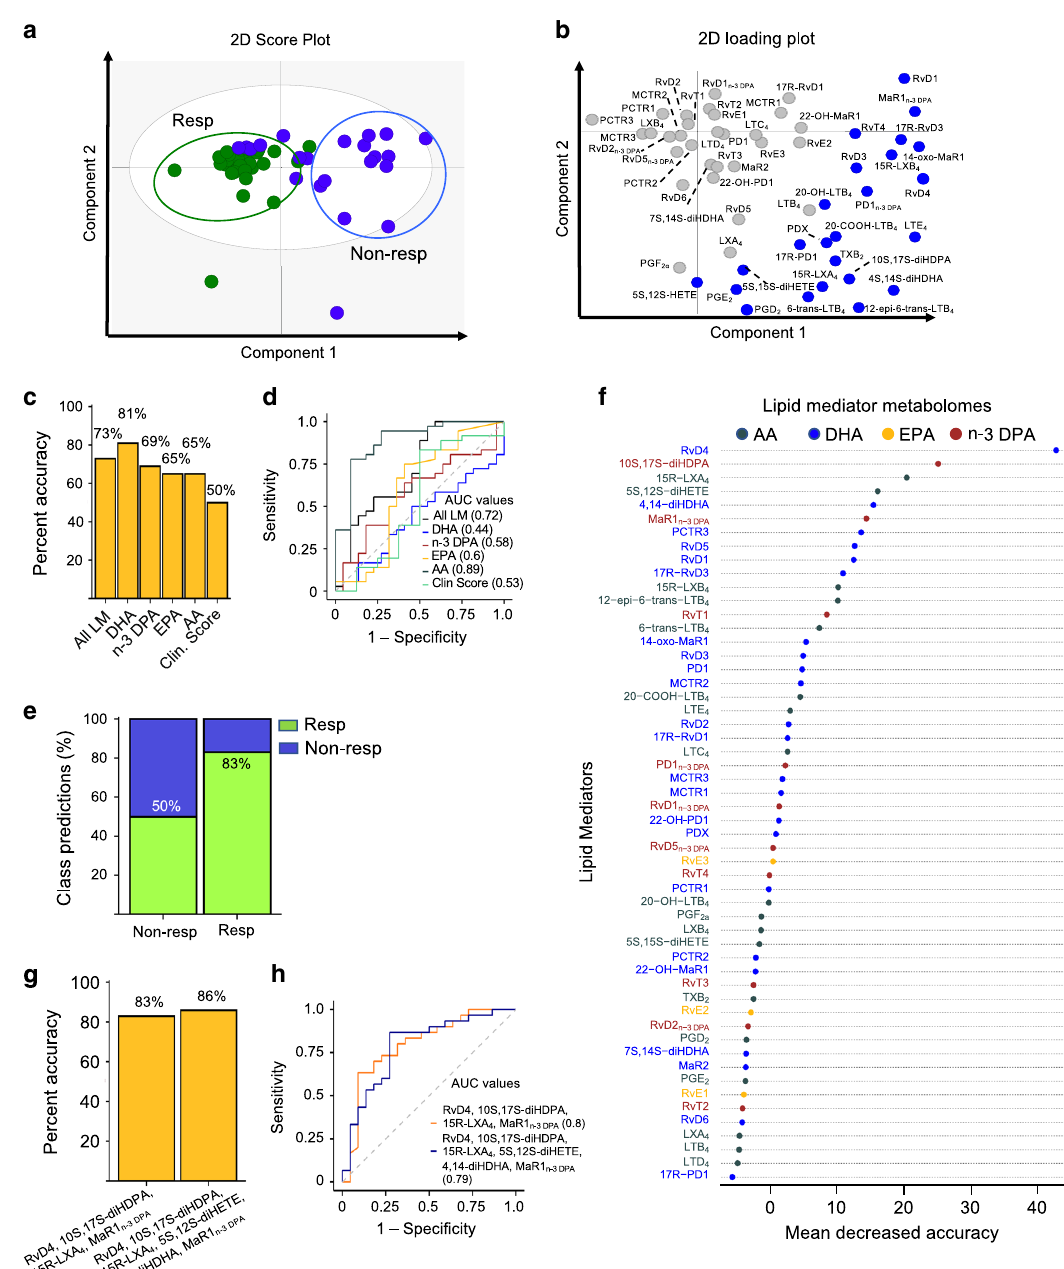
Fig. 1 Baseline lipid mediator pro fi les are predictive of DMARD responsiveness in RA patients. Plasma was collected from RA patients prior to the initiation of treatment with DMARDs and lipid mediator concentrations established using LC-MS/MS-based lipid mediator pro fi ling (see ‘ Methods ’ for details). a , b OPLS-DA analysis of peripheral blood lipid mediator concentrations for DMARD responders (Resp) and DMARD non-responders (Non-Resp). a Two-dimensional score plot. Grey circle represents the 95% con fi dence regions. b Two-dimensional loading plots. Lipid mediators with VIP score >1 are upregulated in Non-Resp and denoted in blue. Results are representative of n = 30 Resp and n = 22 Non-Resp. c Percent accuracy score of prediction models based on the combination of all lipid mediators identi fi ed and quanti fi ed (AL LM) or individual fatty acid metabolomes as indicated. Clin. Score = clinical score (see ‘ Methods ’ for parameters included). d ROC curves and AUC values (provided in brackets) for predictive models. e Classi fi cation predictions for each class (sensitivity and speci fi city) of the n-3 DPA model. Green indicates the samples that were predicted as Resp while blue indicates those patients predicted Non-Resp. Percentages indicate true positives (Resp class) and true negatives (Non-Resp class). f Relevance of lipid mediators in the prediction performance of the “ ALL LM ” model based on decreasing accuracy. g Percent accuracy score of models using the indicated SPM. h ROC curves and AUC values for predictive models based on the indicated SPM. All the models were created using the random forest methodology ( “ randomForest ” package from R). Source data are provided as a Source data fi